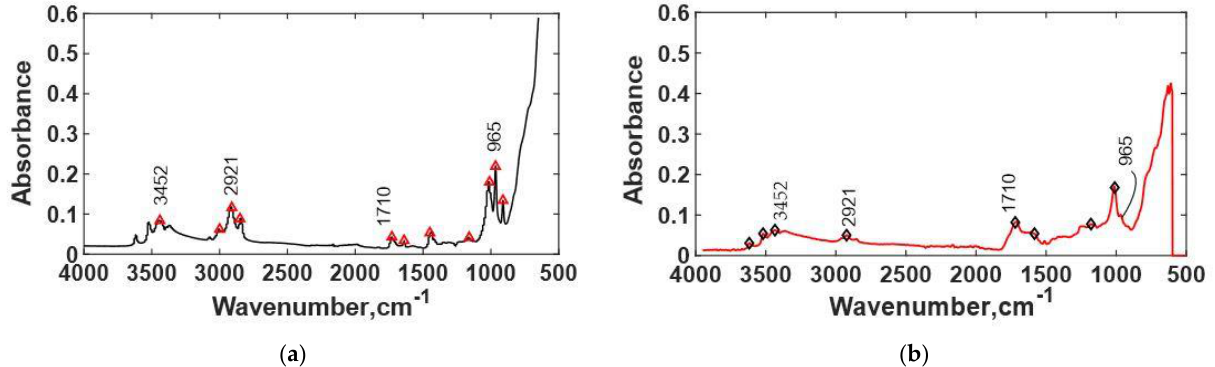
( b ) Figure 16. ( a ) FTIR spectra of TIM A preaged, and ( b ) FTIR spectra of TIM A thermal-aged at 125 °C. FTIR analysis was performed for preaged TIM B and thermal-aged TIM B. The FTIR spectra of TIM B preaged and TIM B thermal-aged at 125 °C are presented in Figure 17. From the FTIR data, it was observed that there is no peak at 1258 cm −1 , so it indicates that it is silicone-free TIM. It was found that CH 3 and CH 2 bonds increase with thermal aging at the 2921 cm −1 wavelength, which indicates polymer chain crosslinking. The FTIR also showed the presence of -OH and C=O functional groups at the wavenumbers 3452 and 1710 cm −1 , respectively. The C=O stretching vibration generally occurred at the 1711 cm −1 wavelength [38]. There was a good possibility that the sample went through thermal oxi-